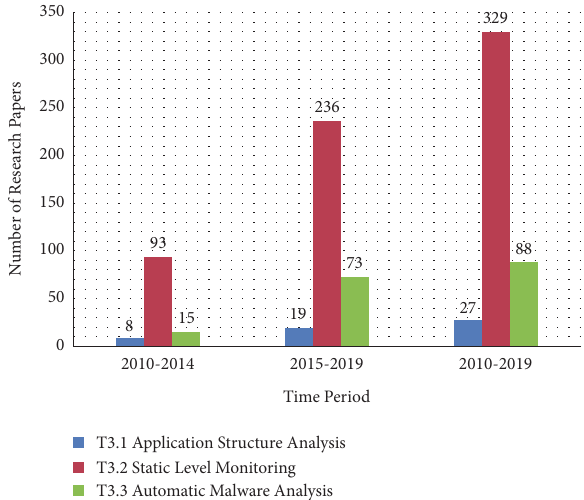
Figure 13: Publication count for three-factor solution during three different time